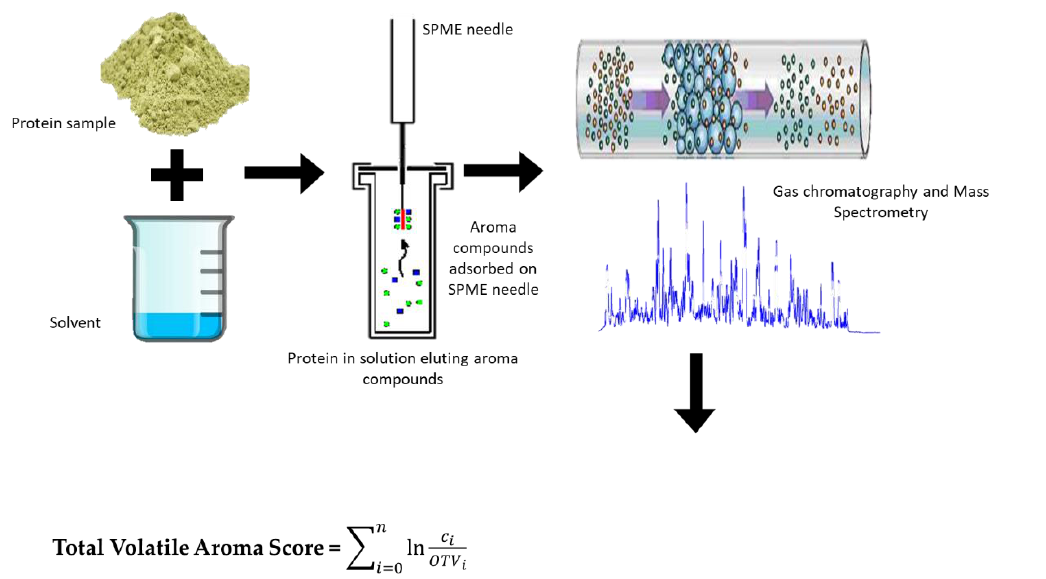
Figure 1. Application of a rapid SPME-GC/MS technique to recover and identify a complex mixture of aroma volatile compounds from proteins.